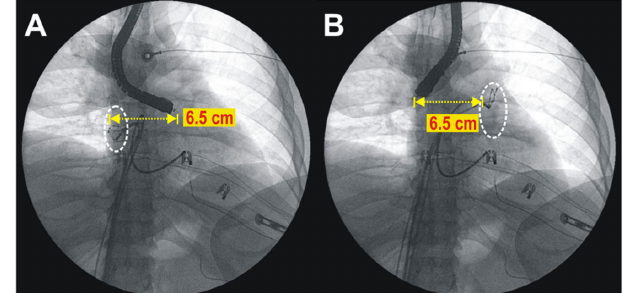
Fig. 2 - Lateral displacement of the esophagus usually obtained during transesophageal echocardiography. In this case the total displacement was 6.5 cm, allowing isolation of the the pulmonary vein (white circles) on each side with a good distance from the esophagus.